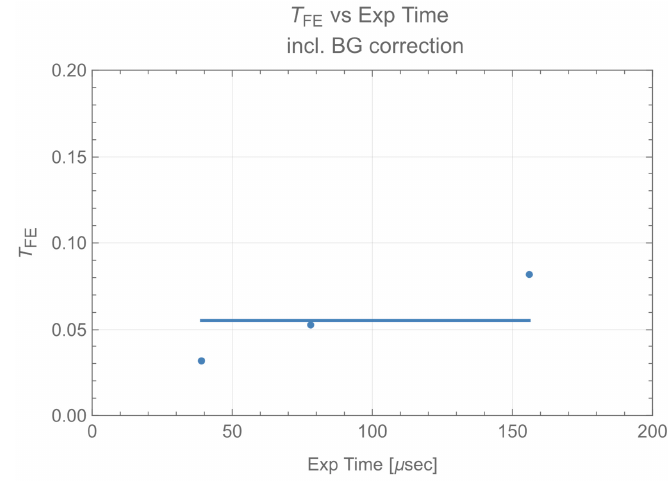
Figure A6. Estimated T FE .